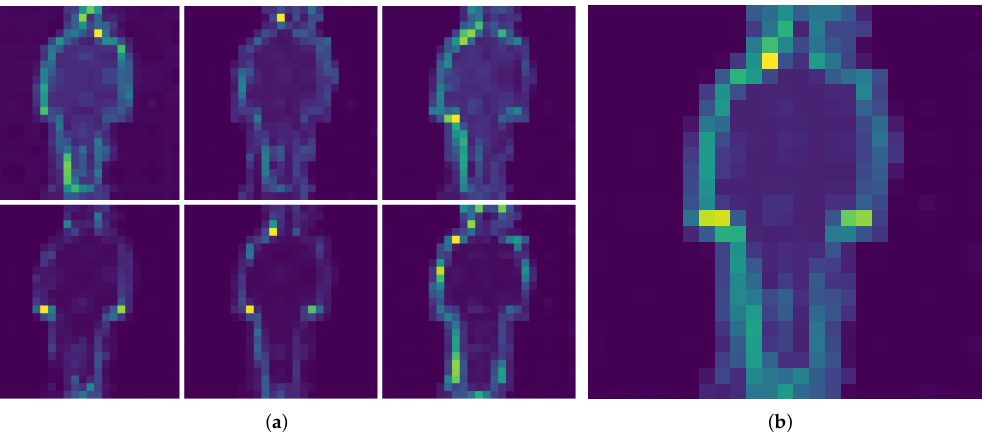
Figure 4. Self-attention of the CLS token on random CASIA-B sample image. ( a ) Self-attention heads. ( b ) Average of all self-attention heads.